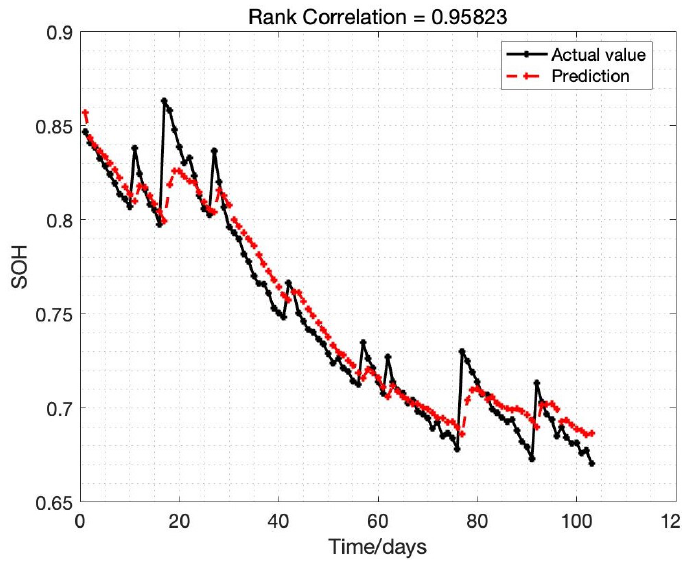
Figure 15. SOH prediction error.